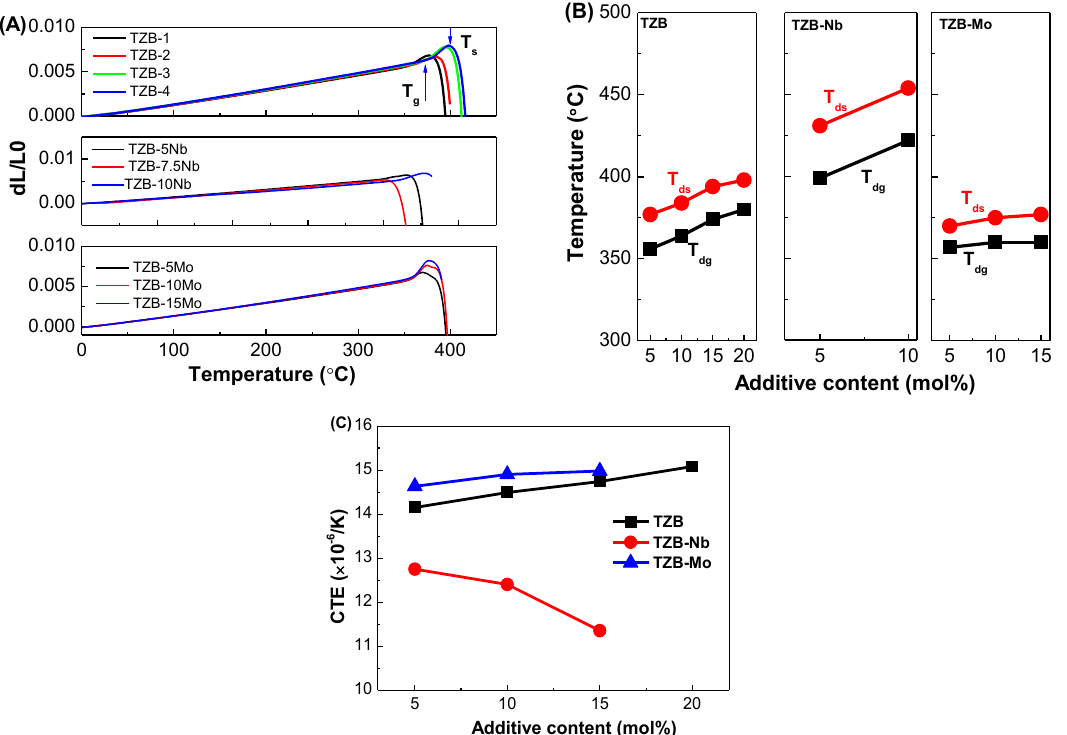
Figure 6. ( A ) Dilatometric curves, ( B ) Quantitative data of dilatometric glass transition temperature (T dg ) and dilatometric softening temperature (T ds ), and ( C ) Coe ffi cient of thermal expansion (CTE) (T dg ) and dilatometric softening temperature (T ds ), and ( C ) Coefficient of thermal expansion (CTE) of the TeO 2 –ZnO–BaO glass system varied with different additive concentrations.